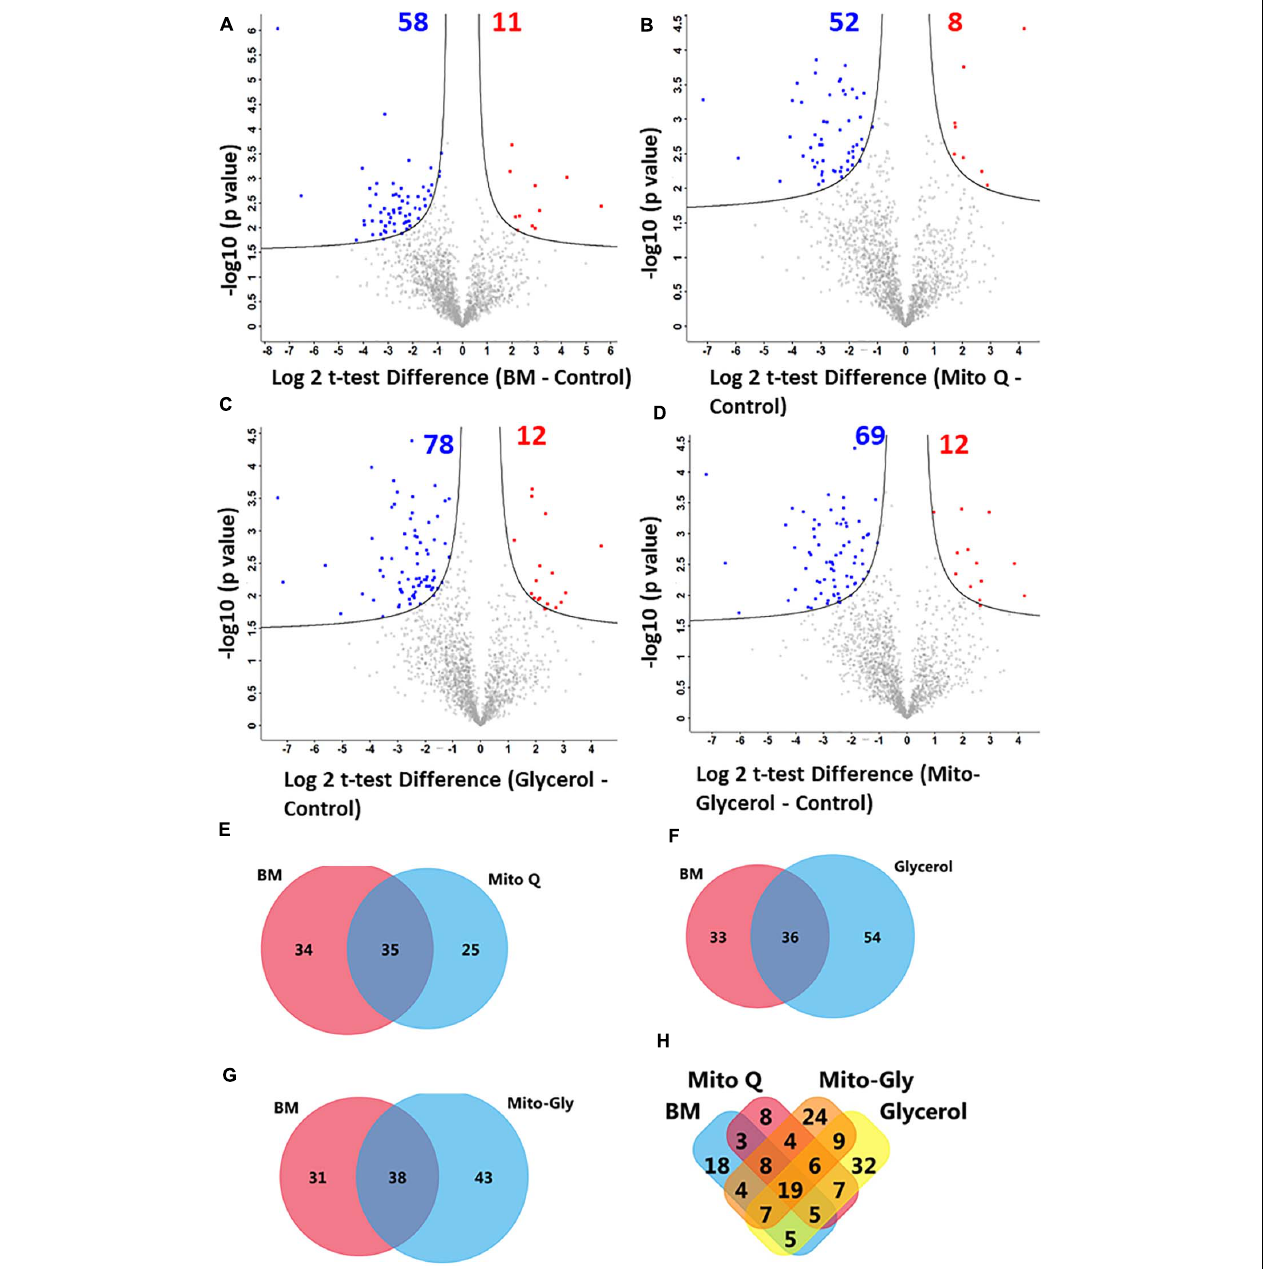
FIGURE 5 | Volcano plots were constructed to identify differentially upregulated and downregulated proteins between vitrified and fresh spermatozoa. Each point represents a protein and the different colors denote the differential expression pattern: red for upregulation, gray for flat regulation, and blue for downregulation. (A) BM vs. fresh. (B) MitoQ vs. fresh. (C) Glycerol vs. fresh. (D) Mito-Gly vs. fresh. Black solid lines represent the significance threshold at FDR = 0.01 and S 0 = 0.1. (E – H) Venn diagrams comparing the differentially expressed proteins among the treatment groups: (E) BM vs. MitoQ. (F) BM vs. glycerol. (G) BM vs. Mito-Gly. (H) All treatment groups. MitoQ , mitoquinone; BM , basal vitrification medium; Mito-Gly , 0.02 µ M MitoQ and 1% glycerol.